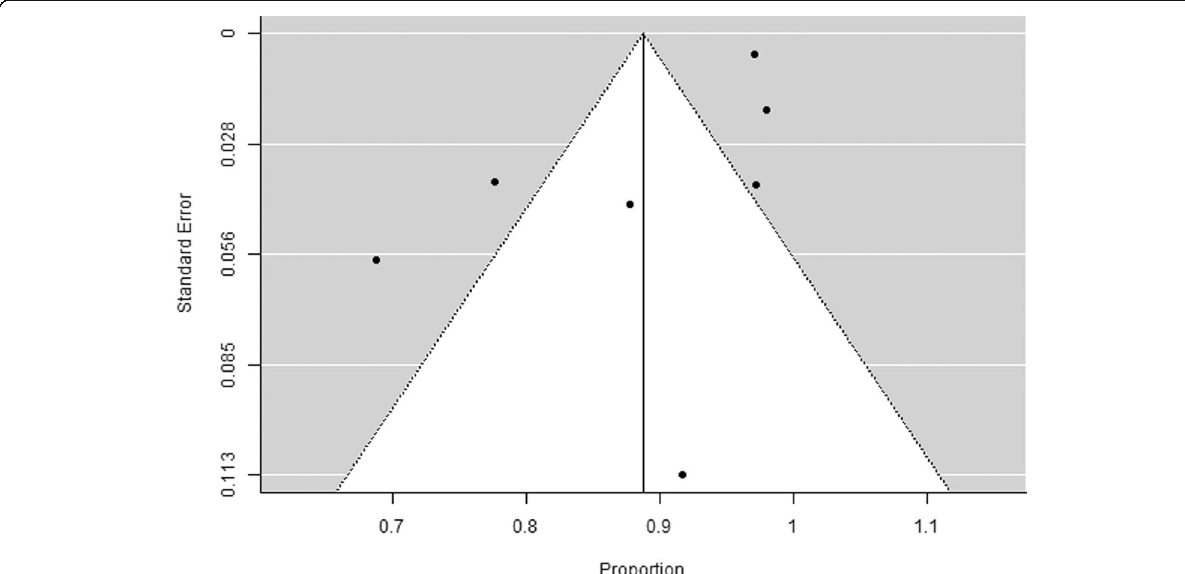
Fig. 2 Funnel plot for sensitivity of the initial CT scan. There is no evidence of publication bias (Rosenthal fail-safe number = 37,526, rank correlation test for funnel plot asymmetry P value = 0.239, regression test for funnel plot asymmetry P value = 0.300)